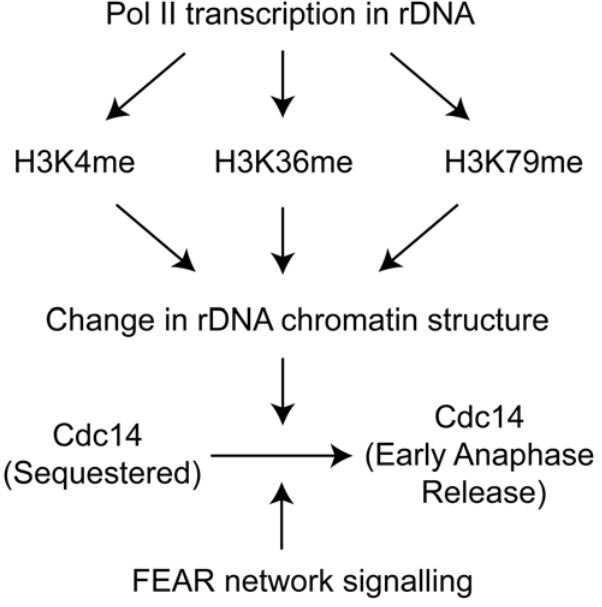
Figure 7. Nonredundant roles for histone modifications in promoting early anaphase release of Cdc14. This model proposes that the three known histone methylations present in S. cerevisiae function nonredundantly to change nucleolar chromatin structure and permit FEAR pathway signaling.